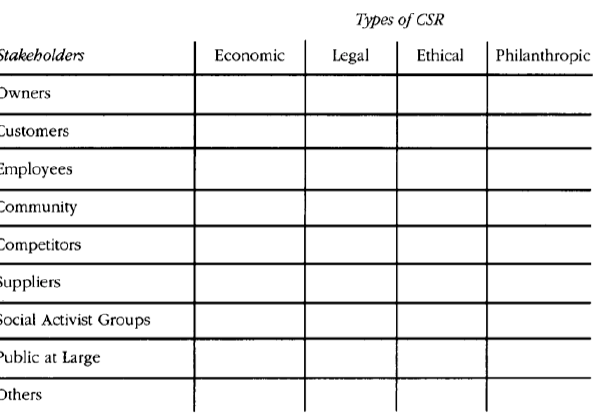
/ responsibility matrix (Carroll 1991, p. Figure 8. Stakeholder/responsibility matrix (Carroll 1991, p. 44). Figure 8. Stakeholder Figure 8. Stakeholder/responsibility matrix (Carroll 1991, p. 44).